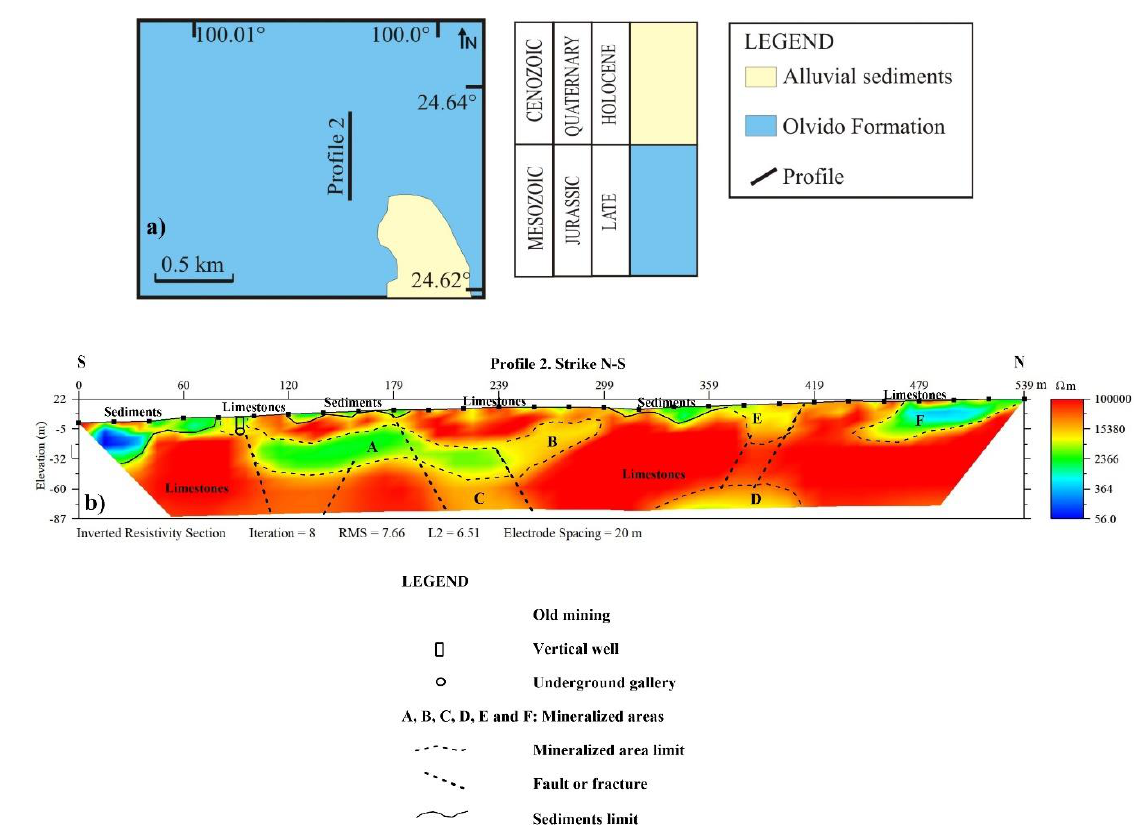
Figure 4. ( a ) Geological map of the Guadalupe mine. Modified from Montañez-Castro [17]. ( b ) Inverted resistivity section. ERT in MVT Ag-Pb-Zn deposit. The stratigraphic column is not to scale.